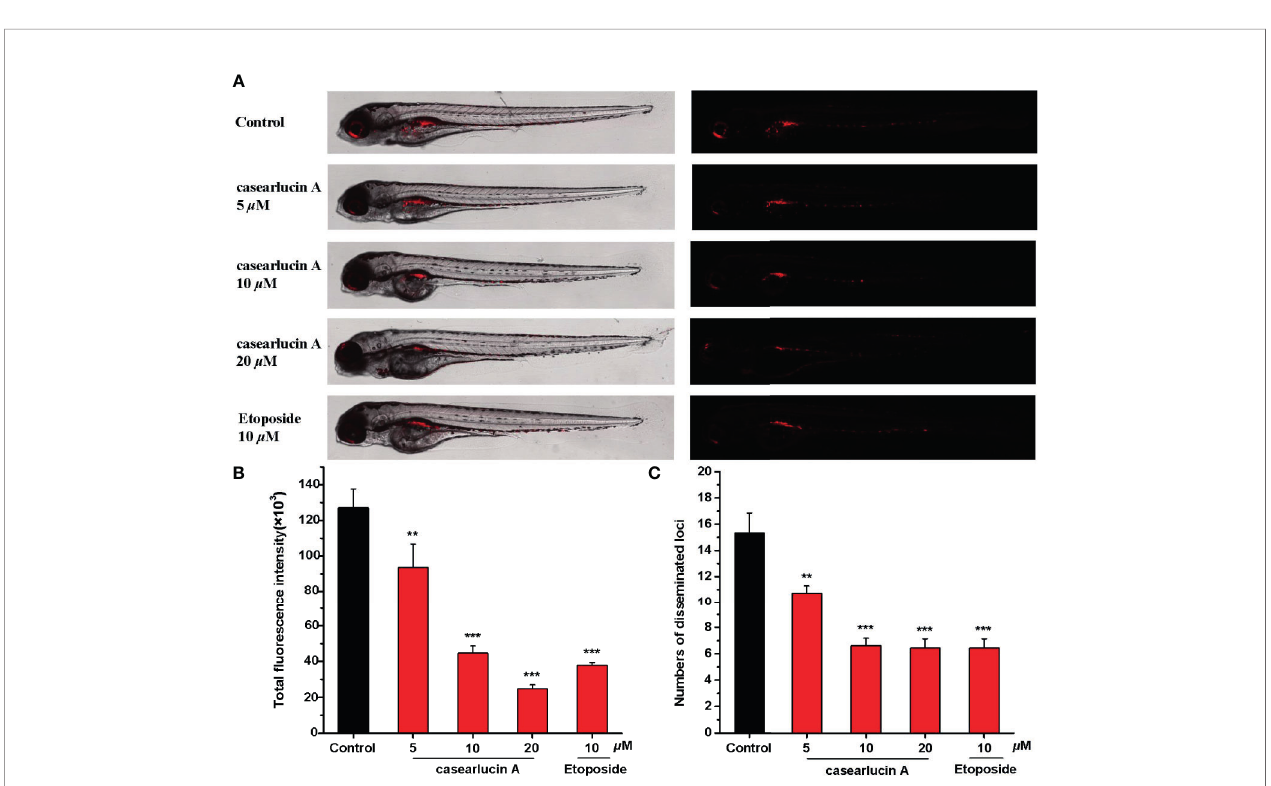
FIGURE 9 | In vivo anti-tumor effects of casearlucin A in zebra fi sh xenografts. CM-DiI stained HepG2 cells were transplanted into 2 dpf zebra fi sh embryos by microinjecting. 4 h later, tumor-bearing embryos were treated with casearlucin A (5, 10, and 20 m M) and etoposide (10 m M) for 48 h (n = 15/group). DMSO was used as a negative control. (A) Intensity and distribution of the red fl uorescence were imaged under a confocal microscope. (B) Fluorescence intensity of the tumor xenografts, representing the number of HepG2 cells. (C) Quanti fi cation of the fl uorescent area of the tumor xenografts, representing HepG2 cell metastasis. Results are expressed as means ± SD. ** p < 0.01 and *** p < 0.001 versus control